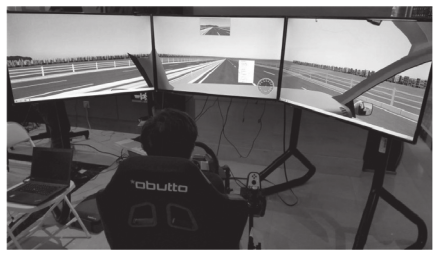
Figure 1: Experimental